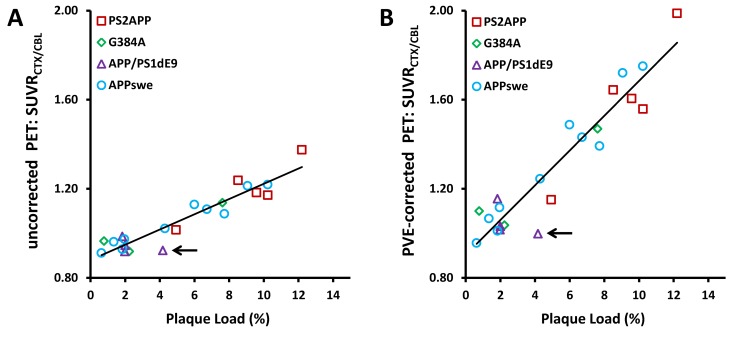
Cross-sectional correlation of plaque load percentage (methoxy-X04 staining) with uncorrected (R = 0.94; p < 0.001) (A) and PVE-corrected (R = 0.95; p < 0.001) (B) [18F]-florbetaben PET results (SUVRCTX/CBL) for PS2APP (red squares; eight months: N = 1; 12 months: N = 2; 19 months: N = 2), G384A (green diamonds; five months: N = 2; 16 months: N = 1), APP/PS1dE9 (purple triangle; 12 months: N = 2; 24 months: N = 2) and APPswe (blue circles; 13 months: N = 2; 20 months: N = 8) mice.A total of 22 hemispheres from 19 animals were examined by histology. Black arrow depicts an APP/PS1dE9 mouse with extensive cerebellar plaque load, which resulted in an anomalously low PET SUVRCTX/CBL.